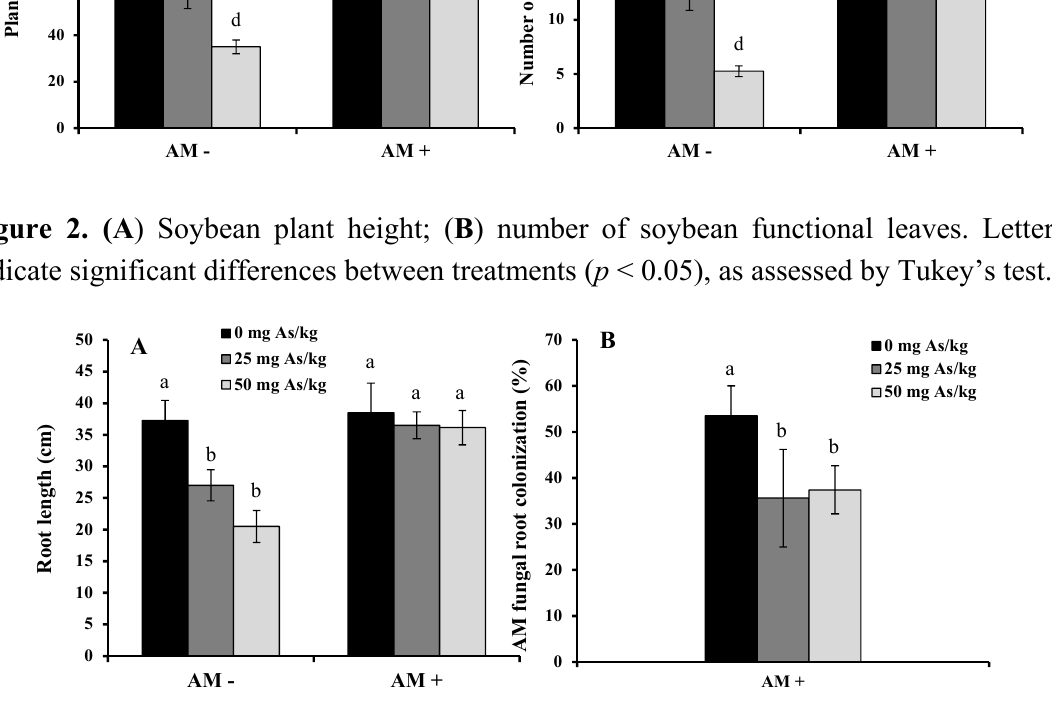
Figure 3. ( A ) Soybean root length; ( B ) mycorrhizal colonization. Letters indicate significant differences between treatments ( p < 0.05), as assessed by Tukey’s